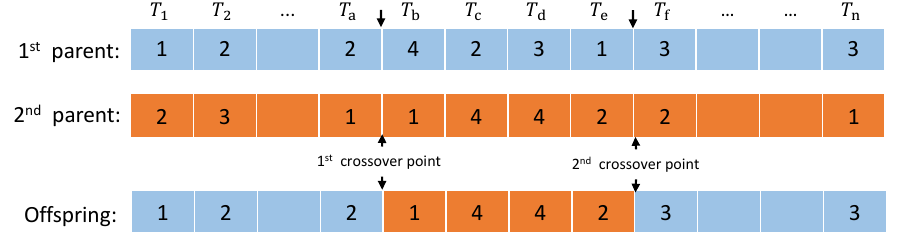
Figure 3. Two-point crossover operator.